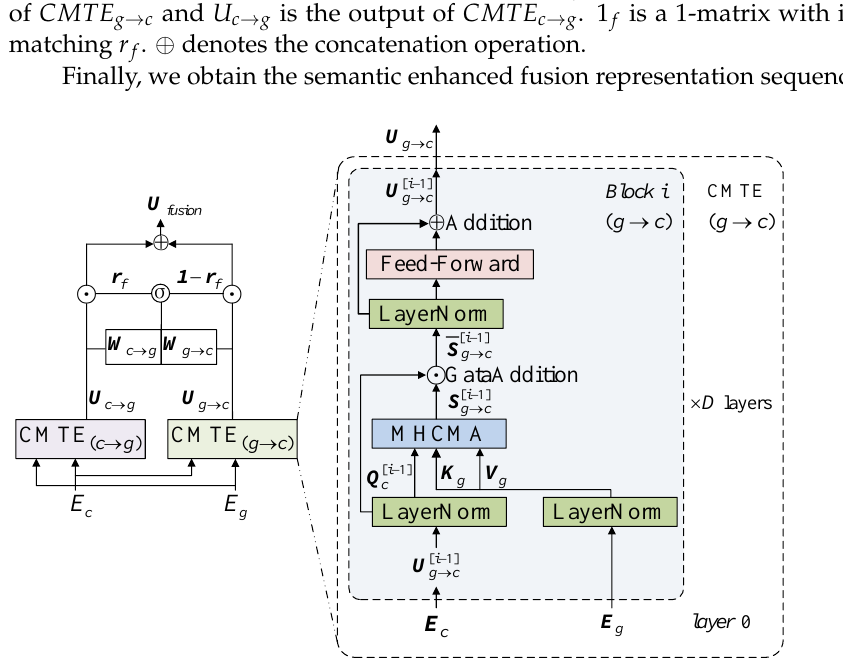
Figure 3. The architecture of the fusion layer consists of two crossmodal Transformer encoders and a gate mechanism. Each crossmodal Transformer encoder is stacked by multiple crossmodal attention